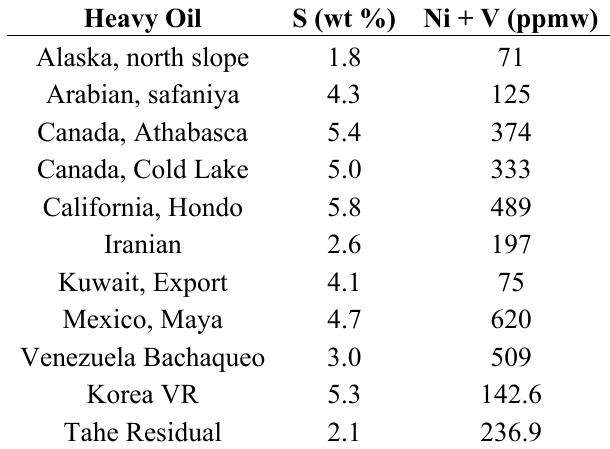
Table 3. Concentration of heteroatoms in heavy oil